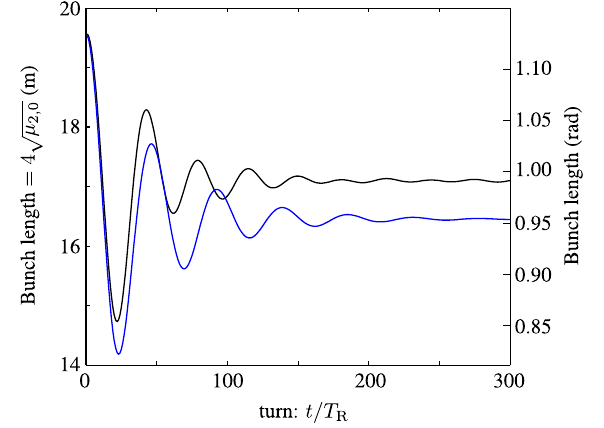
STABILITY OF LONGITUDINAL BUNCH LENGTH . .